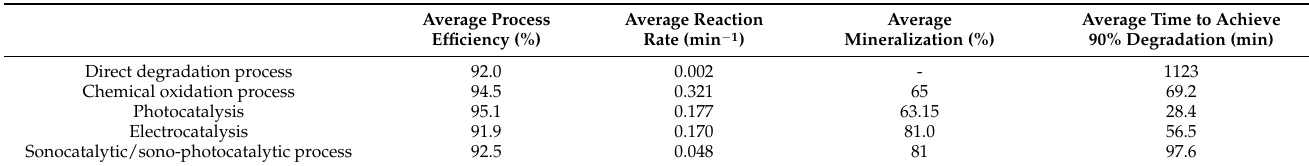
Table 5. Comparative analysis of graphene-based composite techniques for pharmaceutical